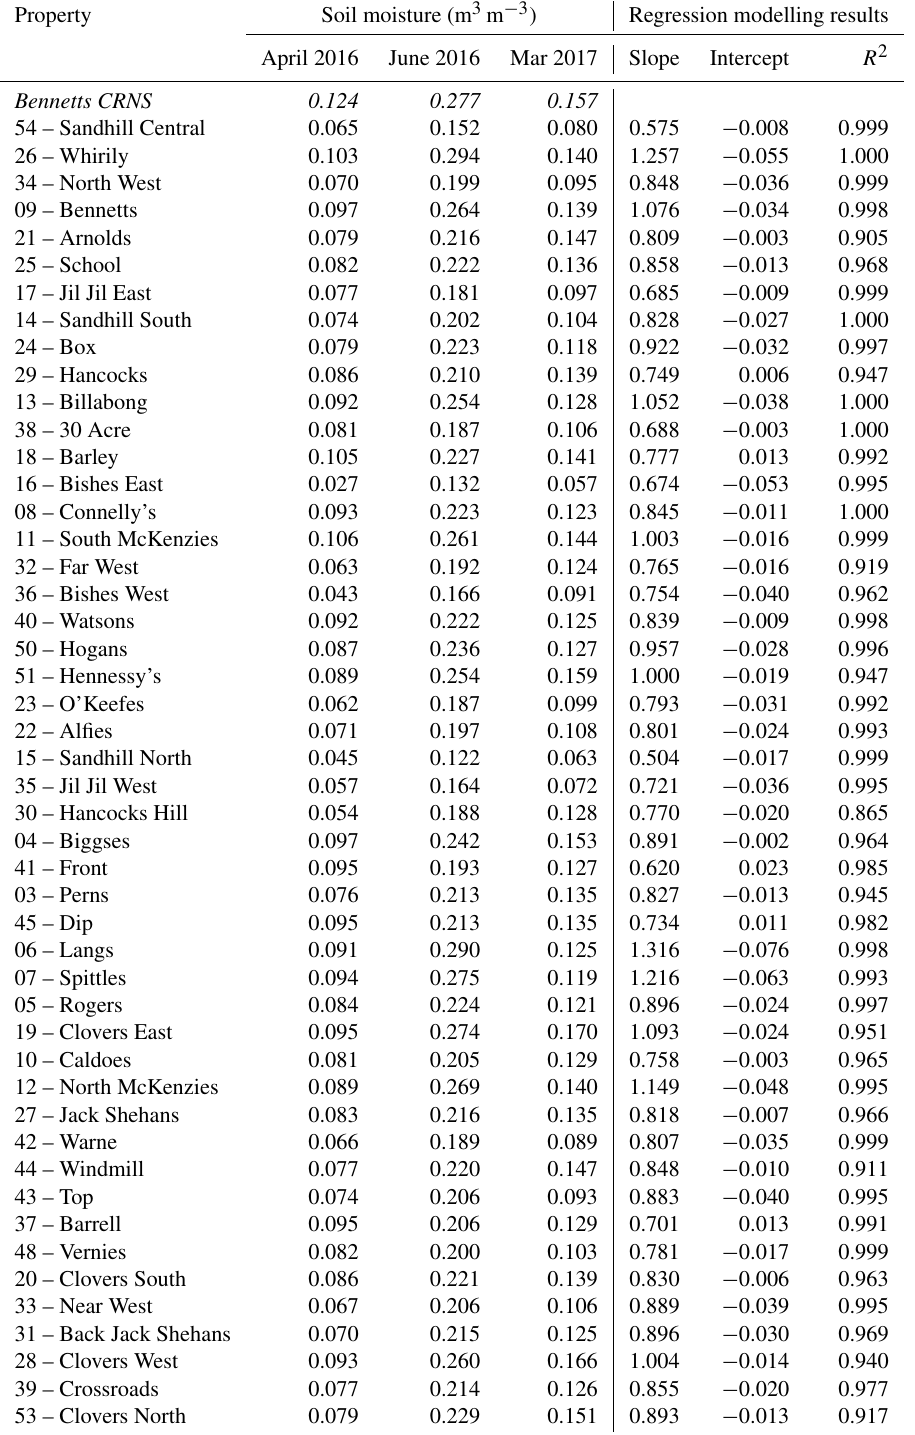
Table A1. Supplementary information from regression analysis relating CRNS observations to property-average soil moisture content in the intensive-scale survey zone. The first line shown in italics is the static CRNS against which all properties are